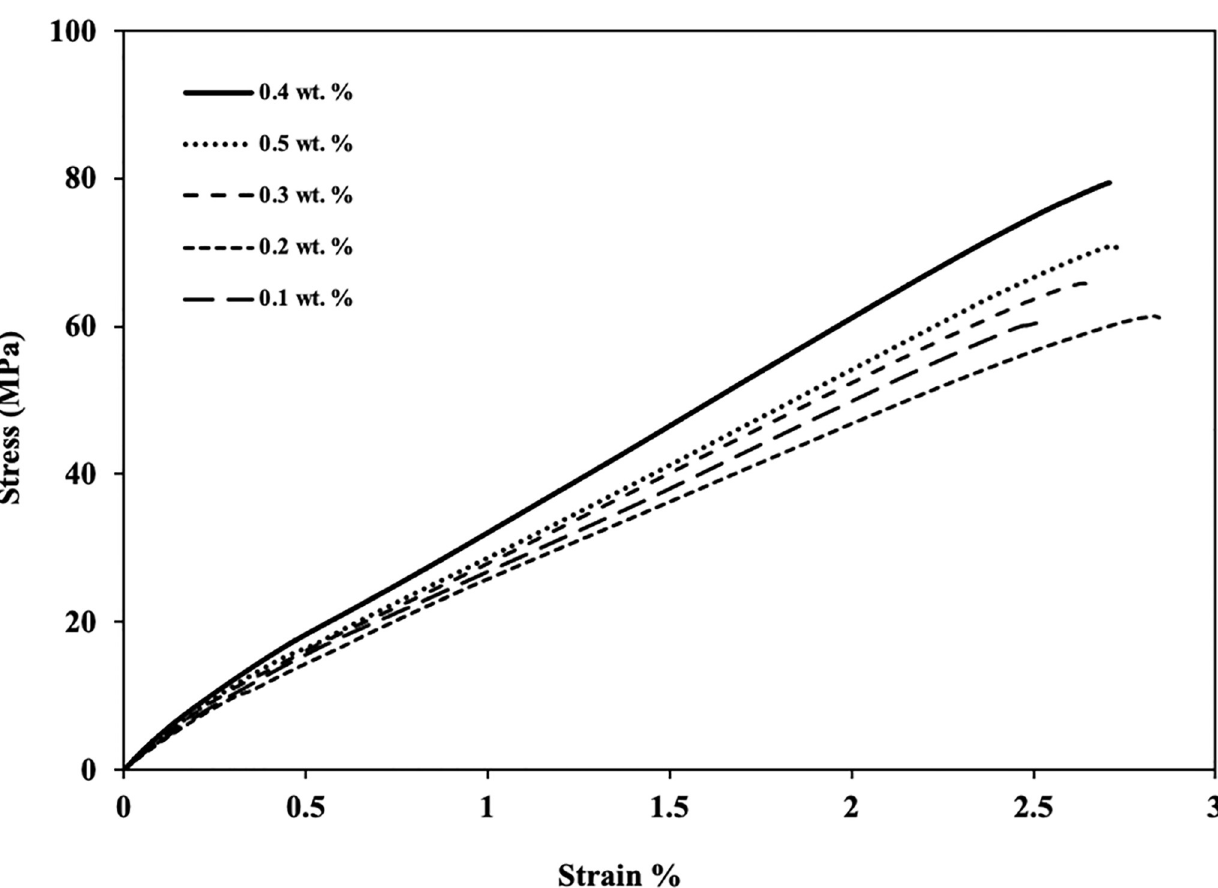
Fig 6. Stress-strain curves of different wt. % f-MWCNTs based modified